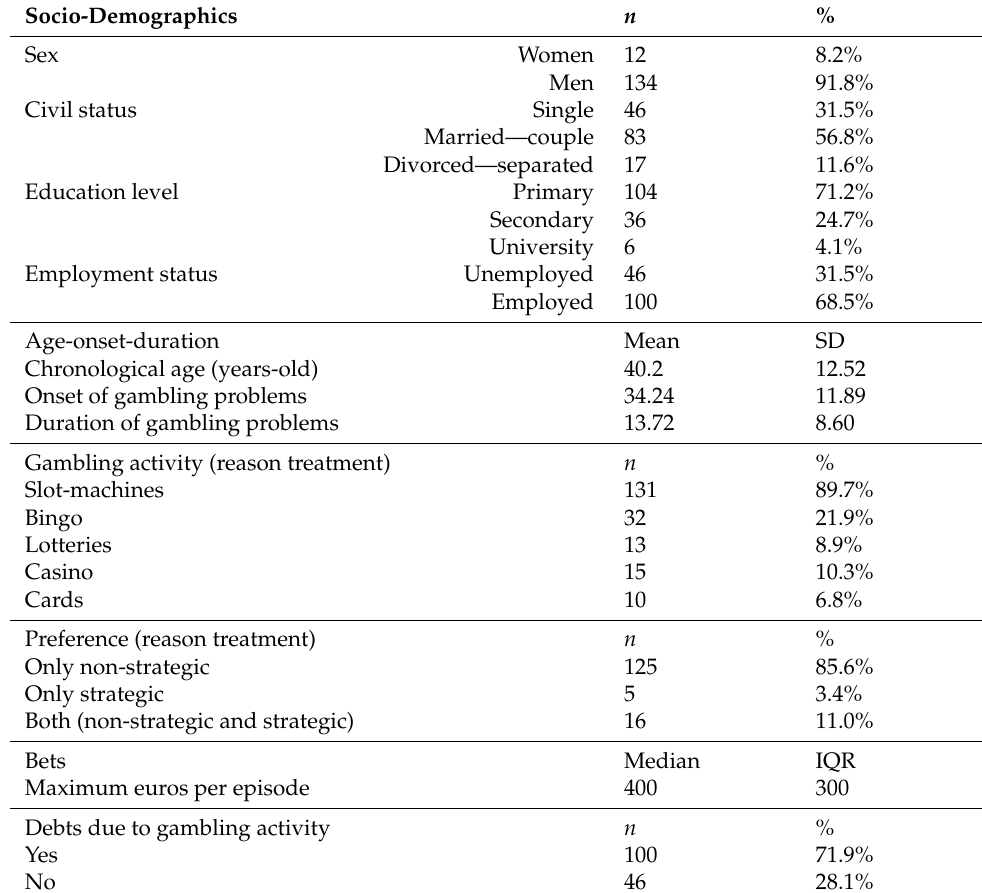
Table 1. Descriptive for the sample ( n = 146).